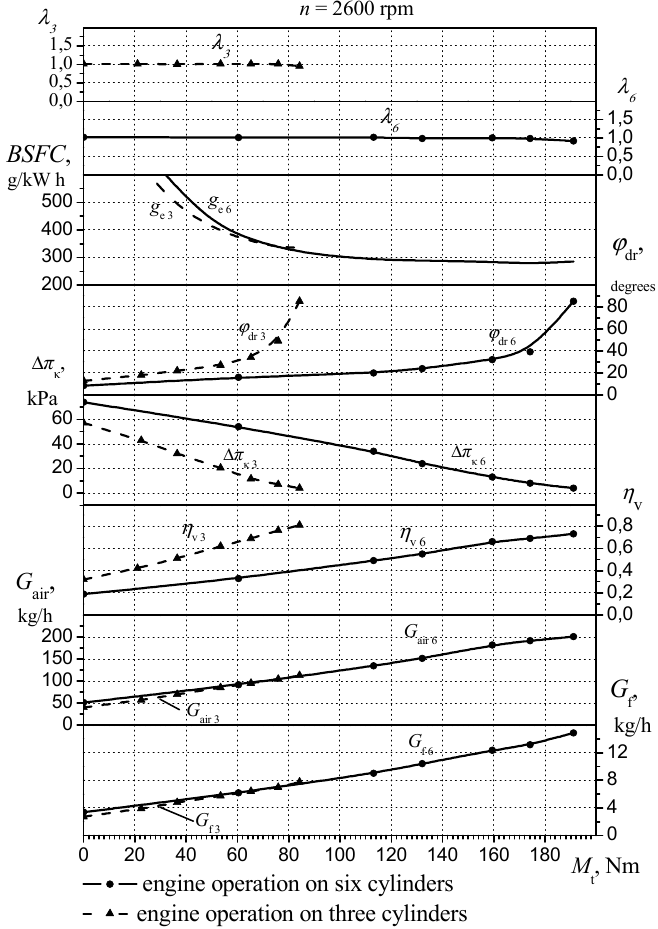
Figure 7. Load characteristics of the Opel C30 LE engine at n = 2600 rpm operating with three and six cylinders.